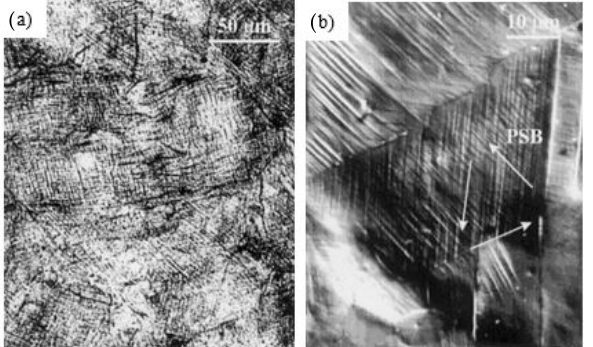
Figure 13. Optical micrographs of cross-section of 316L steel subjected to ( a ) SP; ( b ) LSP. Reproduced with permission from [115]. Copyright Elsevier,